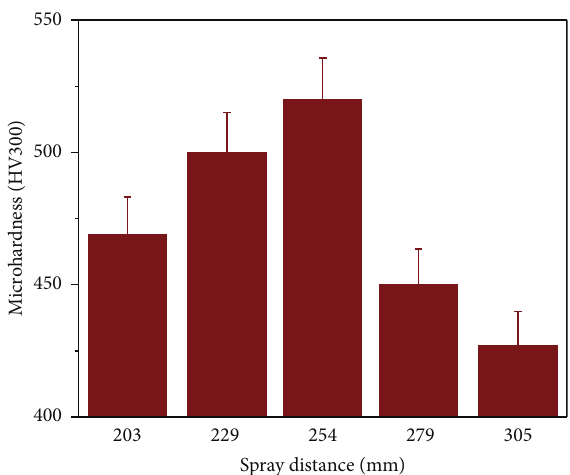
Figure 8: Bond strength Co 32 Ni 21 Cr 8 Al 0.5 Y coatings. (a) Depend- ing on the spray distance and (b) depending on the